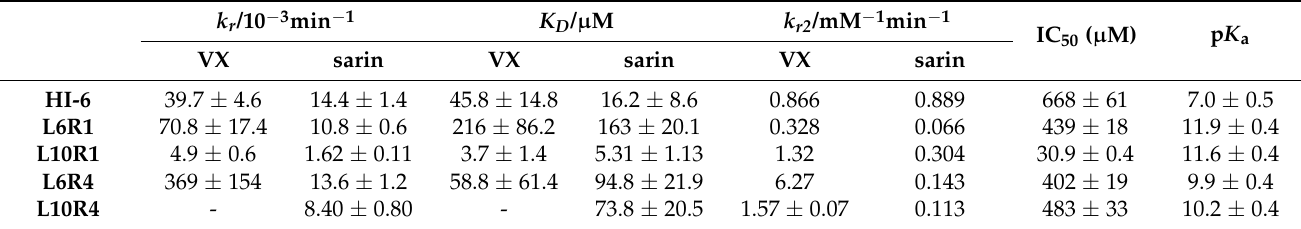
Table 1. Reactivation rate constant ( k r ), dissociation constant ( K D ), second order reactivation rate constant ( k r2 ) of HI-6 and novel non-oxime reactivators for nerve agent inhibited hAChE. IC 50 and predicted p K a of these